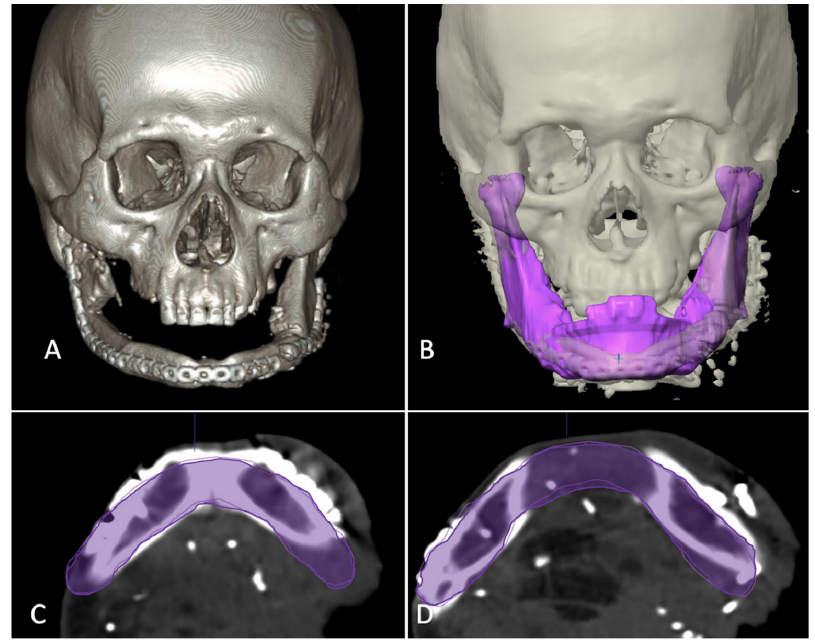
Figure 9. Superimposition of planned and postoperative image in category II. ( A ) 3-dimensional view of outcome after reconstruction. ( B ) Superimposition of virtual plan (purple color) and post-operative data. ( C , D ) Axial view showing good match of reconstructed fibula to simulated mandi- ble.